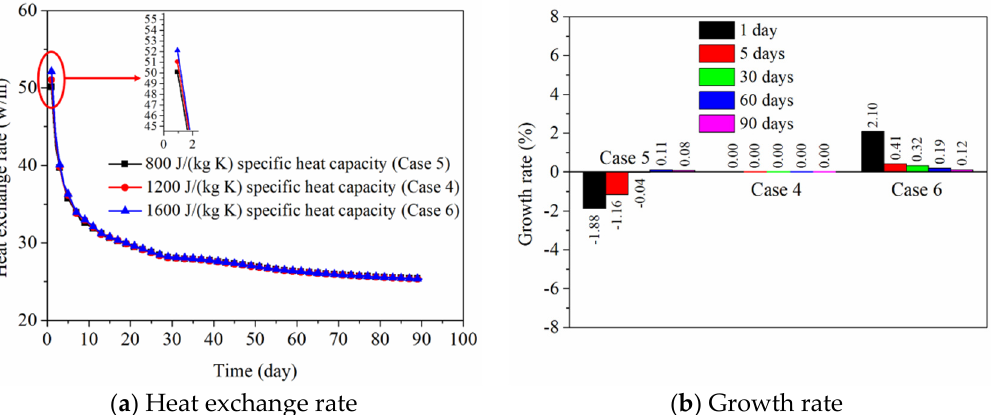
Figure 13. Effect of specific heat capacity of backfill soil in PHC pile on the thermal performance of energy pile.